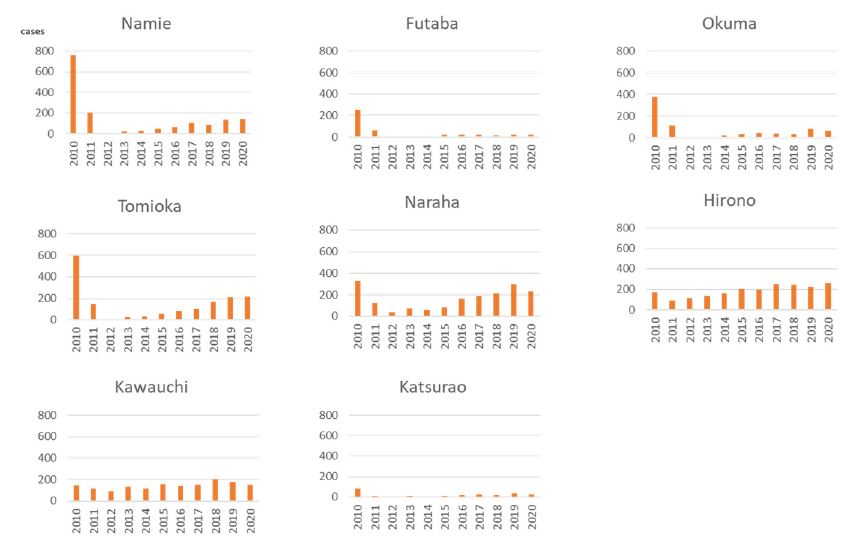
Figure 6. Use of ambulances by municipalities before and after the Fukushima accident (2011).